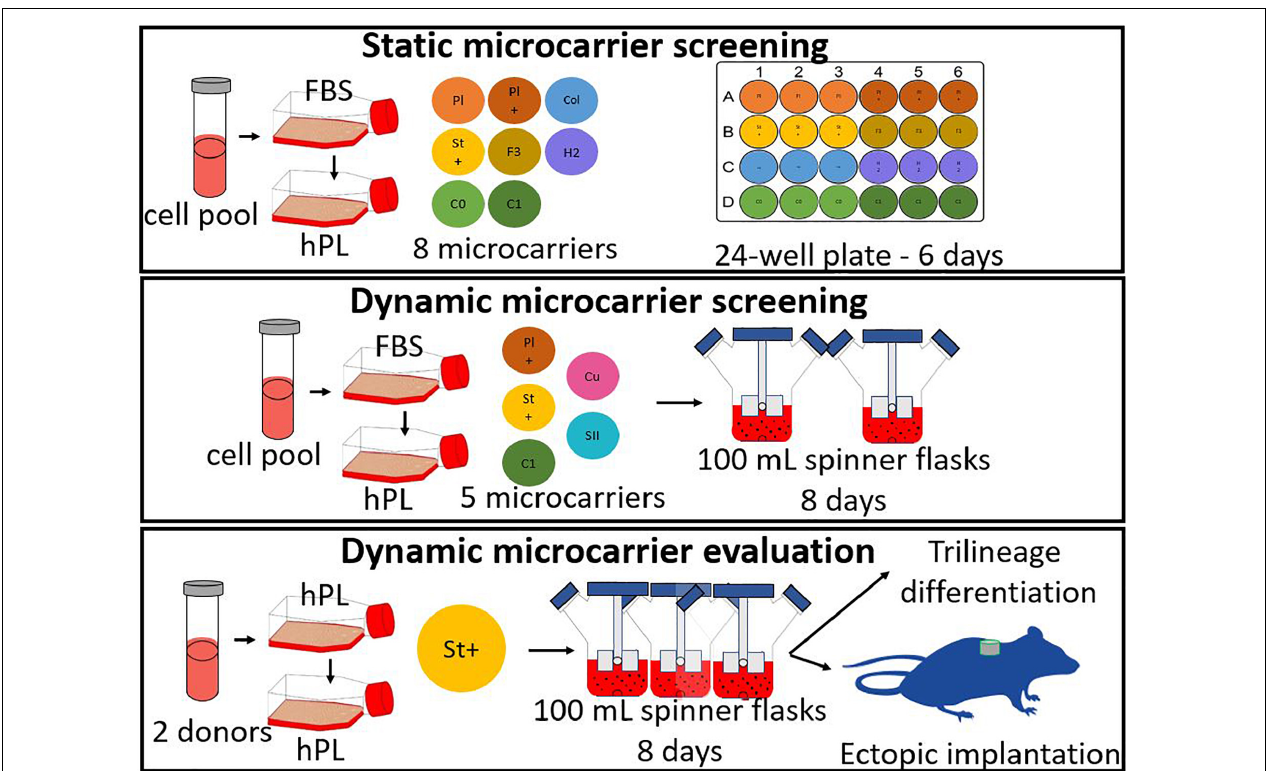
FIGURE 1 | General scheme of the experiments, starting with a static microcarrier screening of 8 microcarriers and followed by a dynamic microcarrier screening of 5 microcarriers. The final experiment evaluated the hPDCs, which were dynamically expanded on the chosen microcarrier Star-Plus, in vitro as well as in vivo